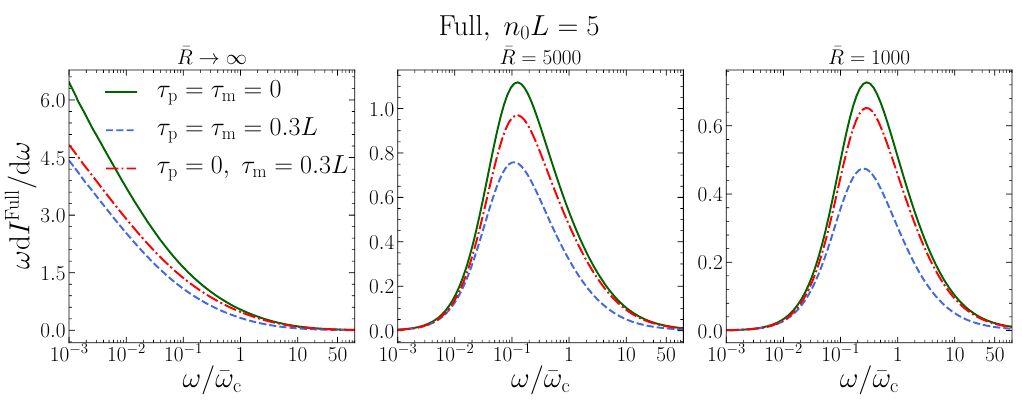
Figure 3 . Fully resummed medium-induced energy spectrum for the three scenarios: τ p = τ m = 0 (green solid lines); τ p = τ m = 0 . 3 L (blue dashed lines); and τ p = 0 and τ m = 0 . 3 L (red dash-dotted lines) as function of ω/ ¯ ω c for n 0 L = 5 . The different panels correspond to different sets of ¯ R : ¯ R → ∞ (left), ¯ R = 5000 (central), and ¯ R = 1000